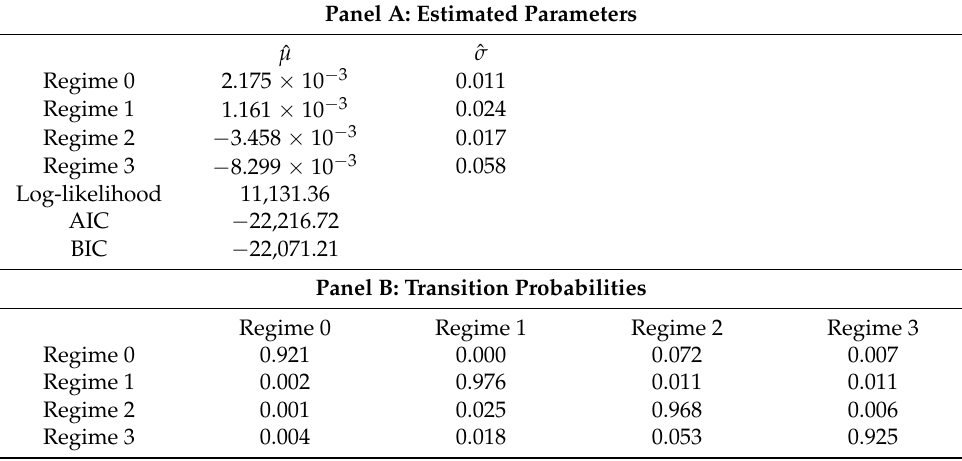
Table 12. Four-regime Markov switching models: estimated parameters for the RTSI index returns (years 2005–2020). AIC and BIC are the Akaike and Bayesian Information Criterion, respectively. Panel A: Estimated Parameters